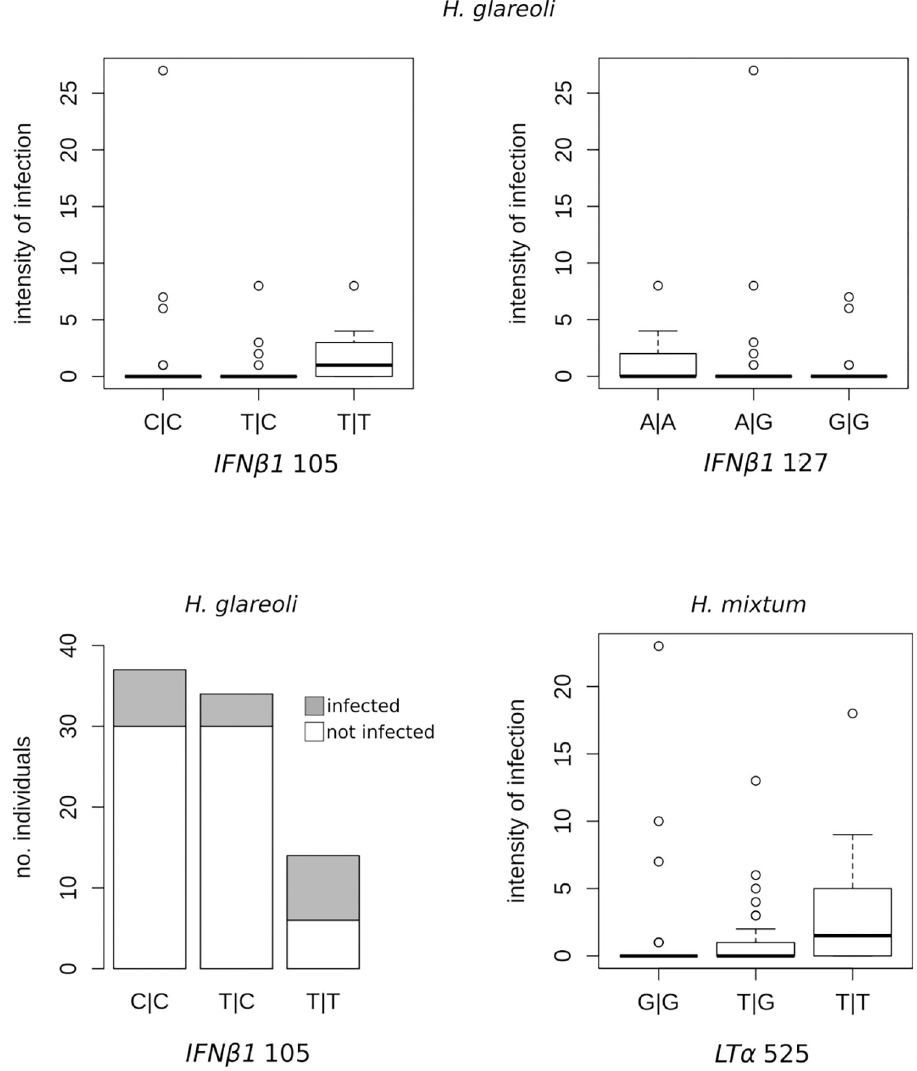
Fig 1. Effect of SNP genotypes in LT α and IFN β 1 on the risk of infection and parasite abundance. Infection intensity is expressed as the number of worms per host); the top and bottom of a box are 25 and 75% percentiles, the outliers are points 1.5 times the interquartile range above the third